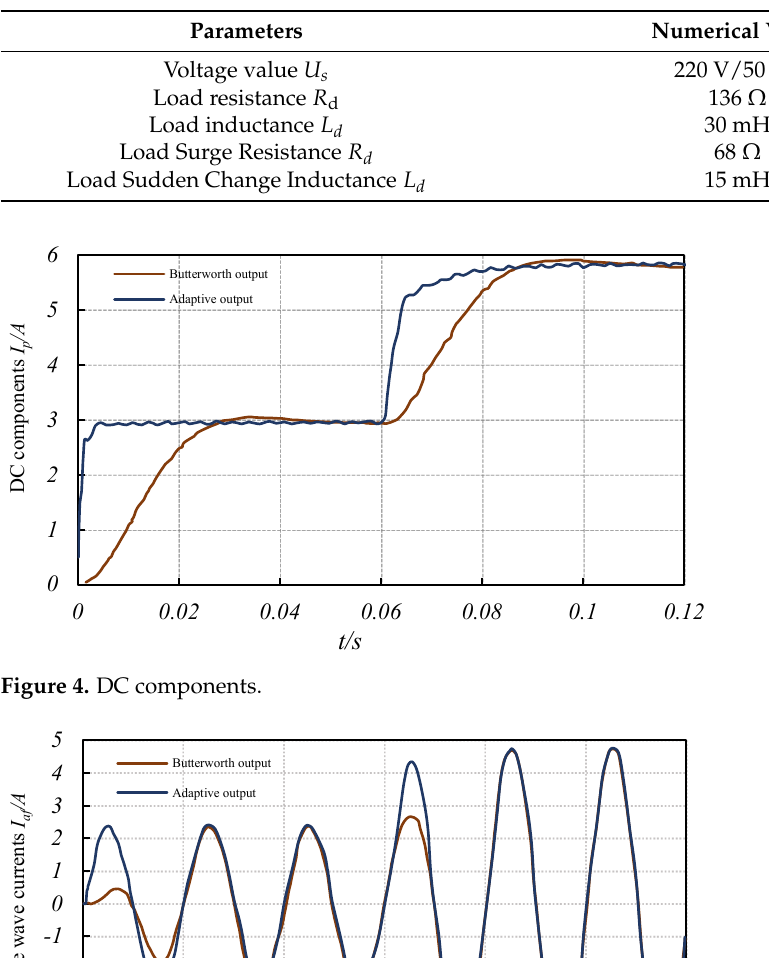
Table 1. Simulation parameters.